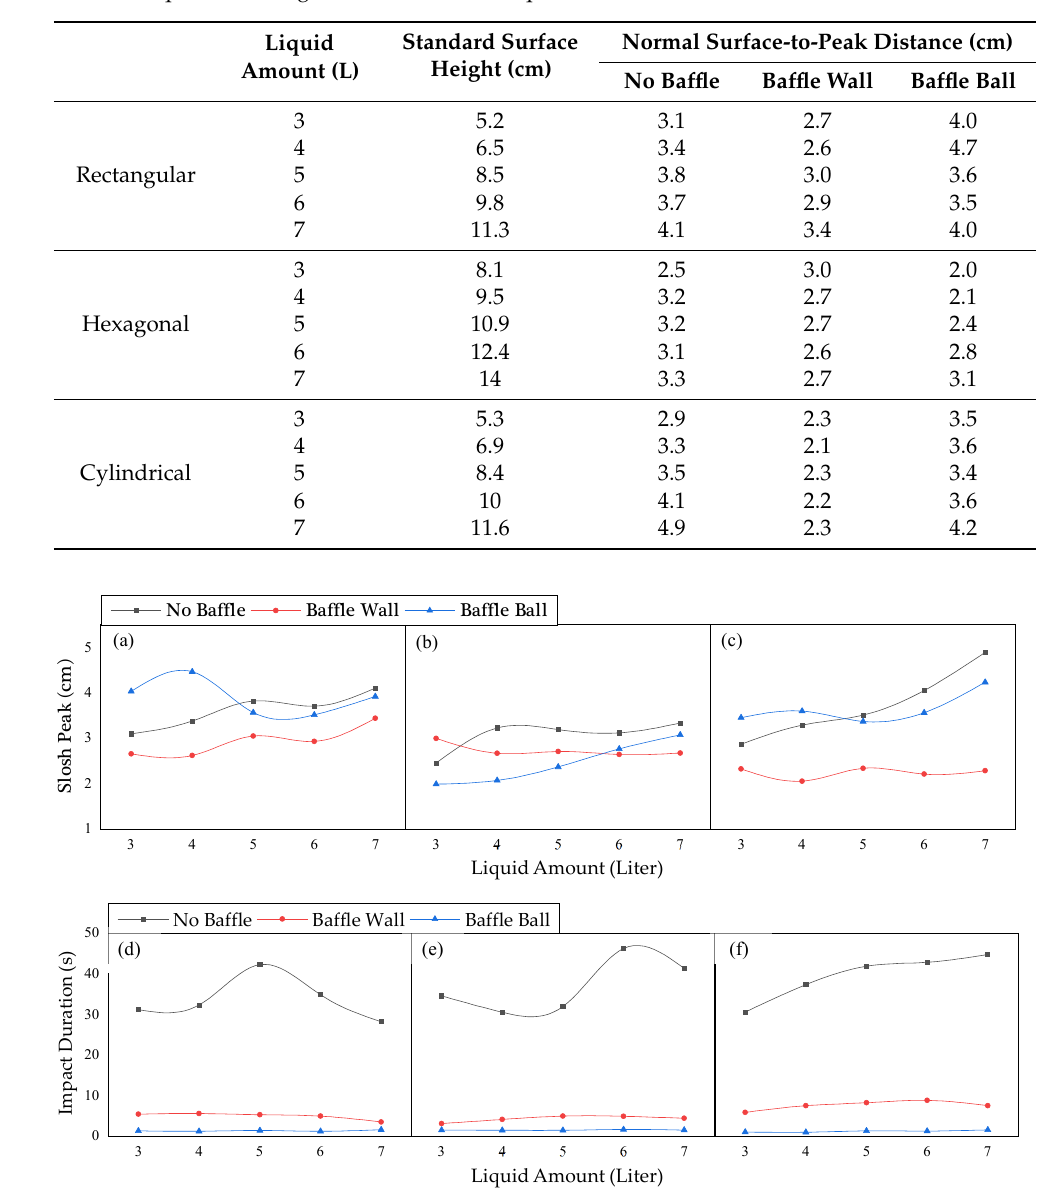
Figure 13. Sloshing-height and duration graph visualization; ( a ) rectangular tank heights, ( b ) hexagonal tank heights, ( c ) cylindrical tank heights, ( d ) rectangular tank durations, ( e ) hexagonal tank durations, and ( f ) cylindrical tank durations.